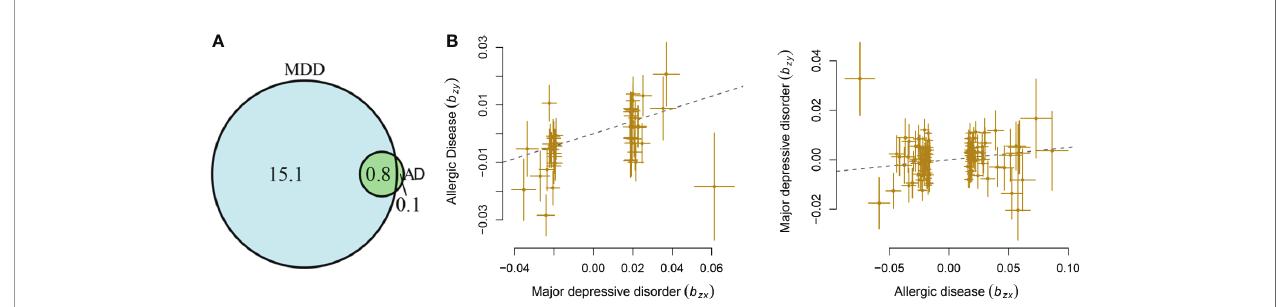
FIGURE 1 | Shared causal variants and causal associations between MDD and ADs. (A) Venn diagrams of unique and shared polygenic components at the causal level, showing a polygenic overlap between MDD and ADs. The numbers indicate the estimated quantity of causal variants (in thousands) per component, explaining